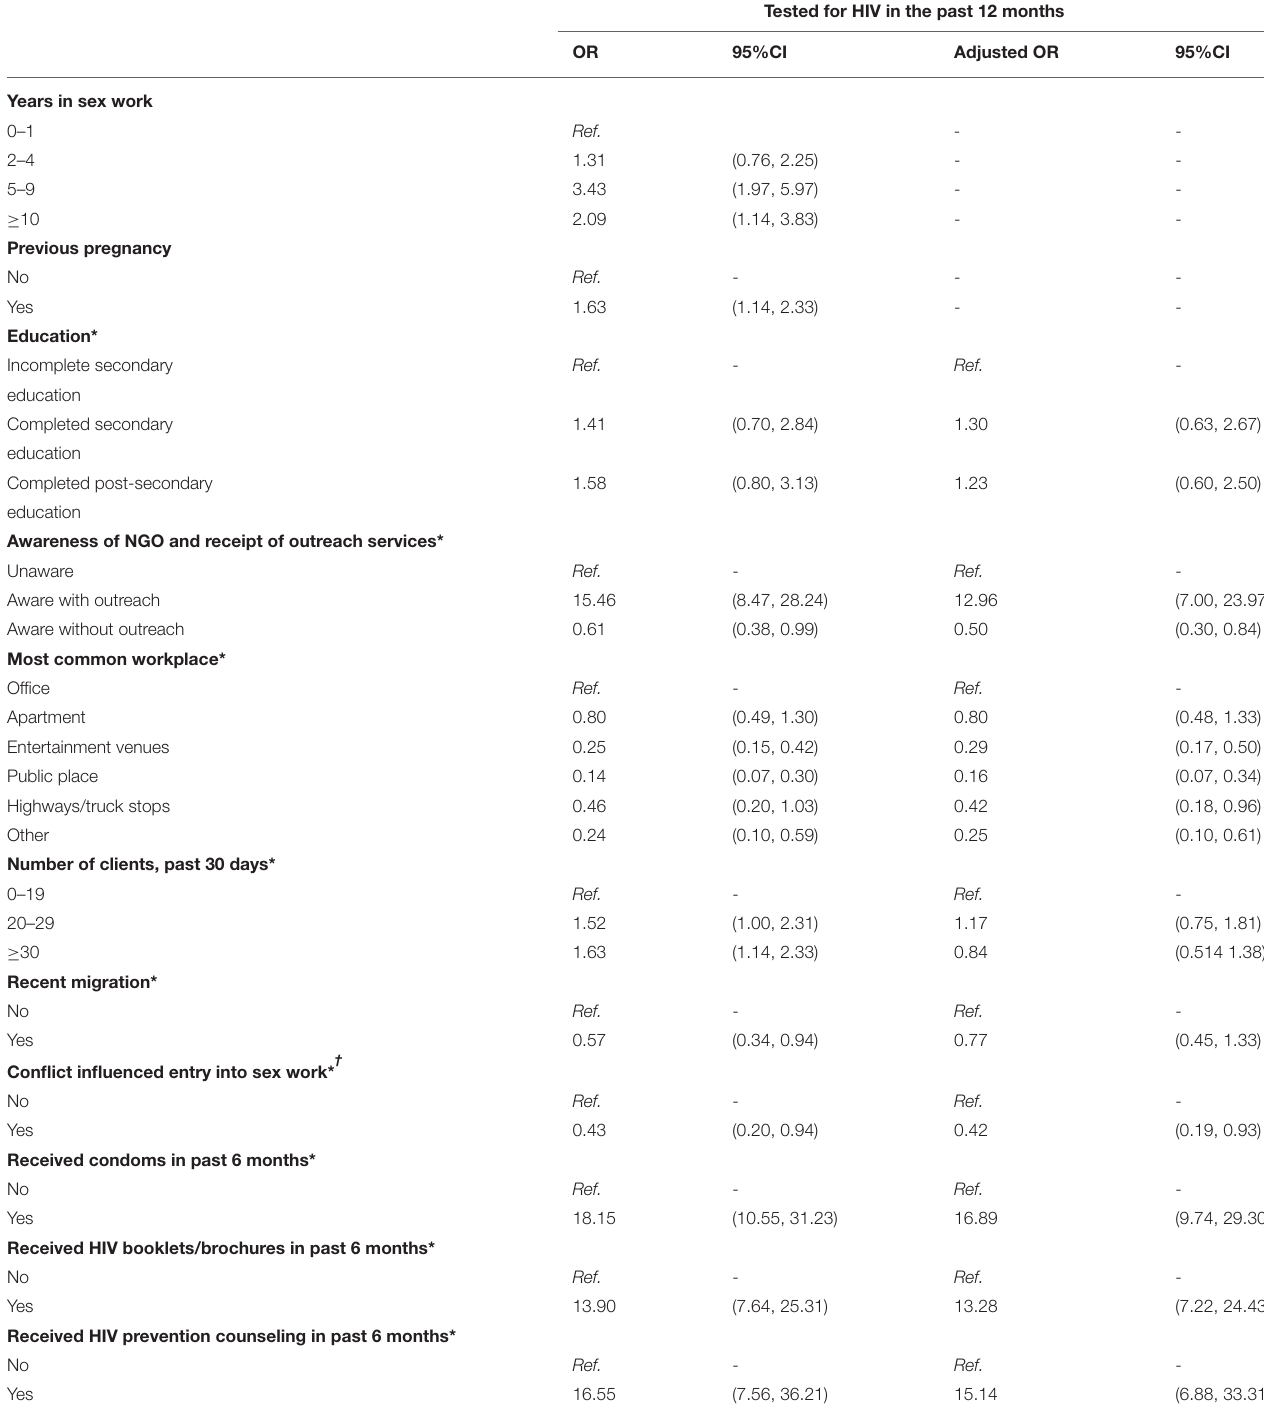
TABLE 4 | Crude (OR) and adjusted odds ratios (AOR) with 95% confidence intervals (95%CI) from logistic regression models examining correlates of HIV testing in the past 12 months among female sex worker